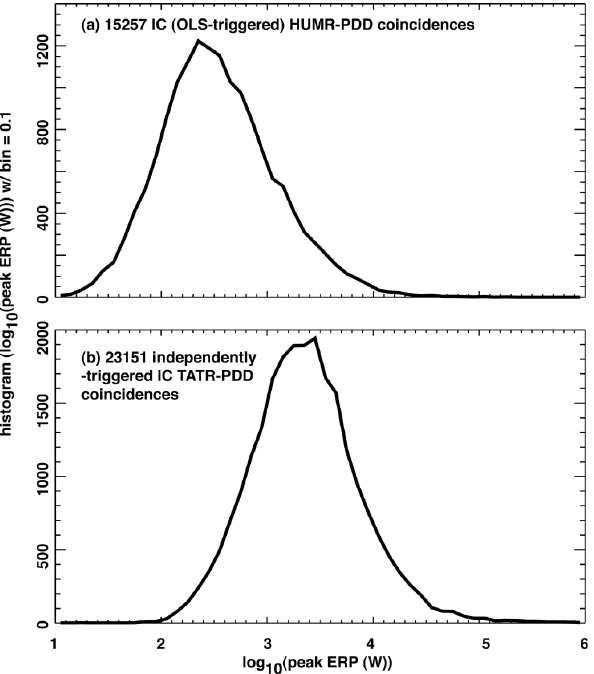
Fig. 2. Histogram of log 10 (peak ERP(W)), with bin size = 0.1. (a) 15257 TIPPs from HUMR records triggered by PDD. (b) 23151 autonomously triggered TIPPs from TATR records coincident with autonomously triggered PDD. Note that, because only TIPPs are in- cluded, the data in this figure are exclusively from intracloud light-